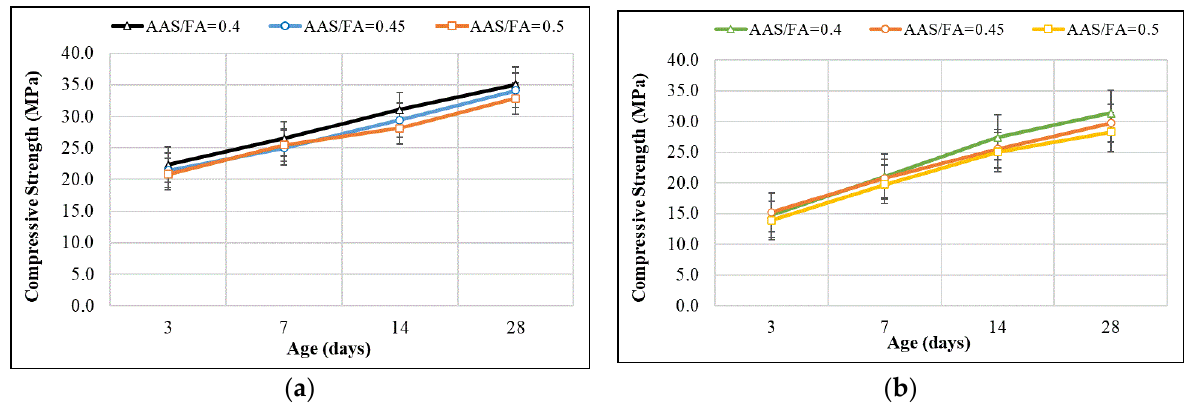
Figure 10. Compressive strength of GRAC with superplasticizer; ( a ) cured at 60 ° C; ( b ) cured at ambient conditions.